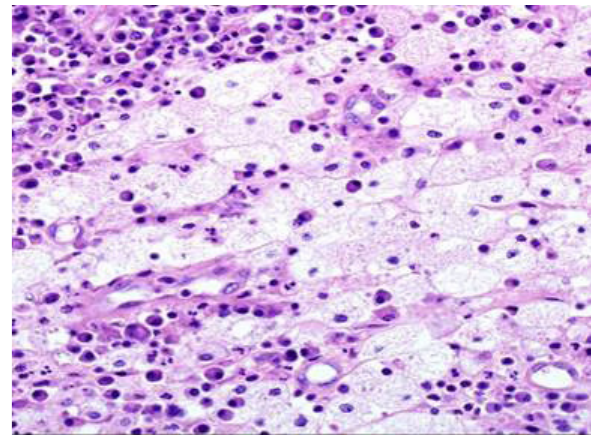
Figure 3: Photomicrograph image showing foam (xanthoma) cells and lymphoplasmacytic inflammation on H&E staining in XGP patient on high